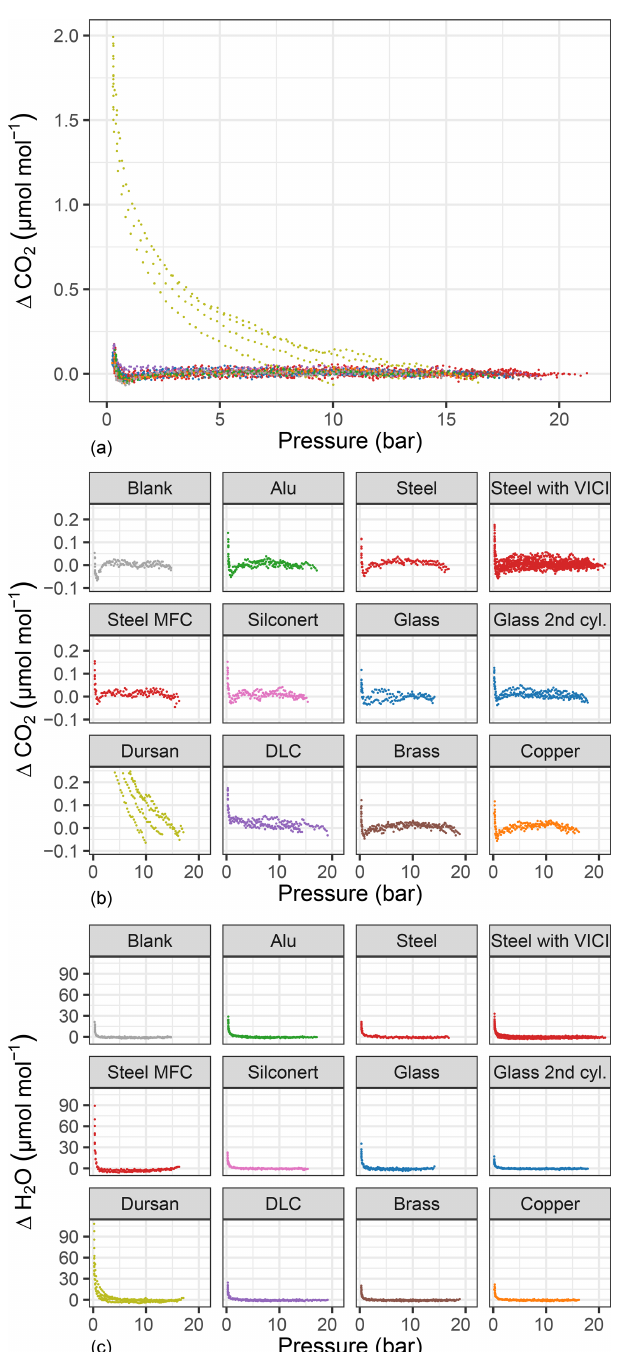
Figure 5. Amount fraction difference relative to the start of the ex- periment for (a, b) CO 2 and (c) H 2 O with respect to pressure for all tested materials. (a) shows all materials together, whereas in (b, c) each material is plotted separately. Consistent color codes are used throughout the